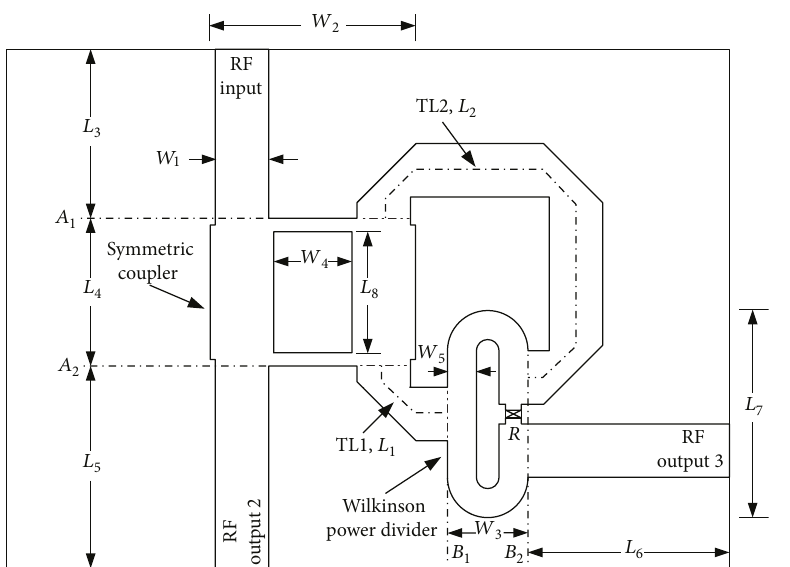
Figure 5: Layout of the three-way divider with C = 7 dB and K = 1 . The ADS layout exported a DWG format fi le, which was inserted and processed in Microsoft